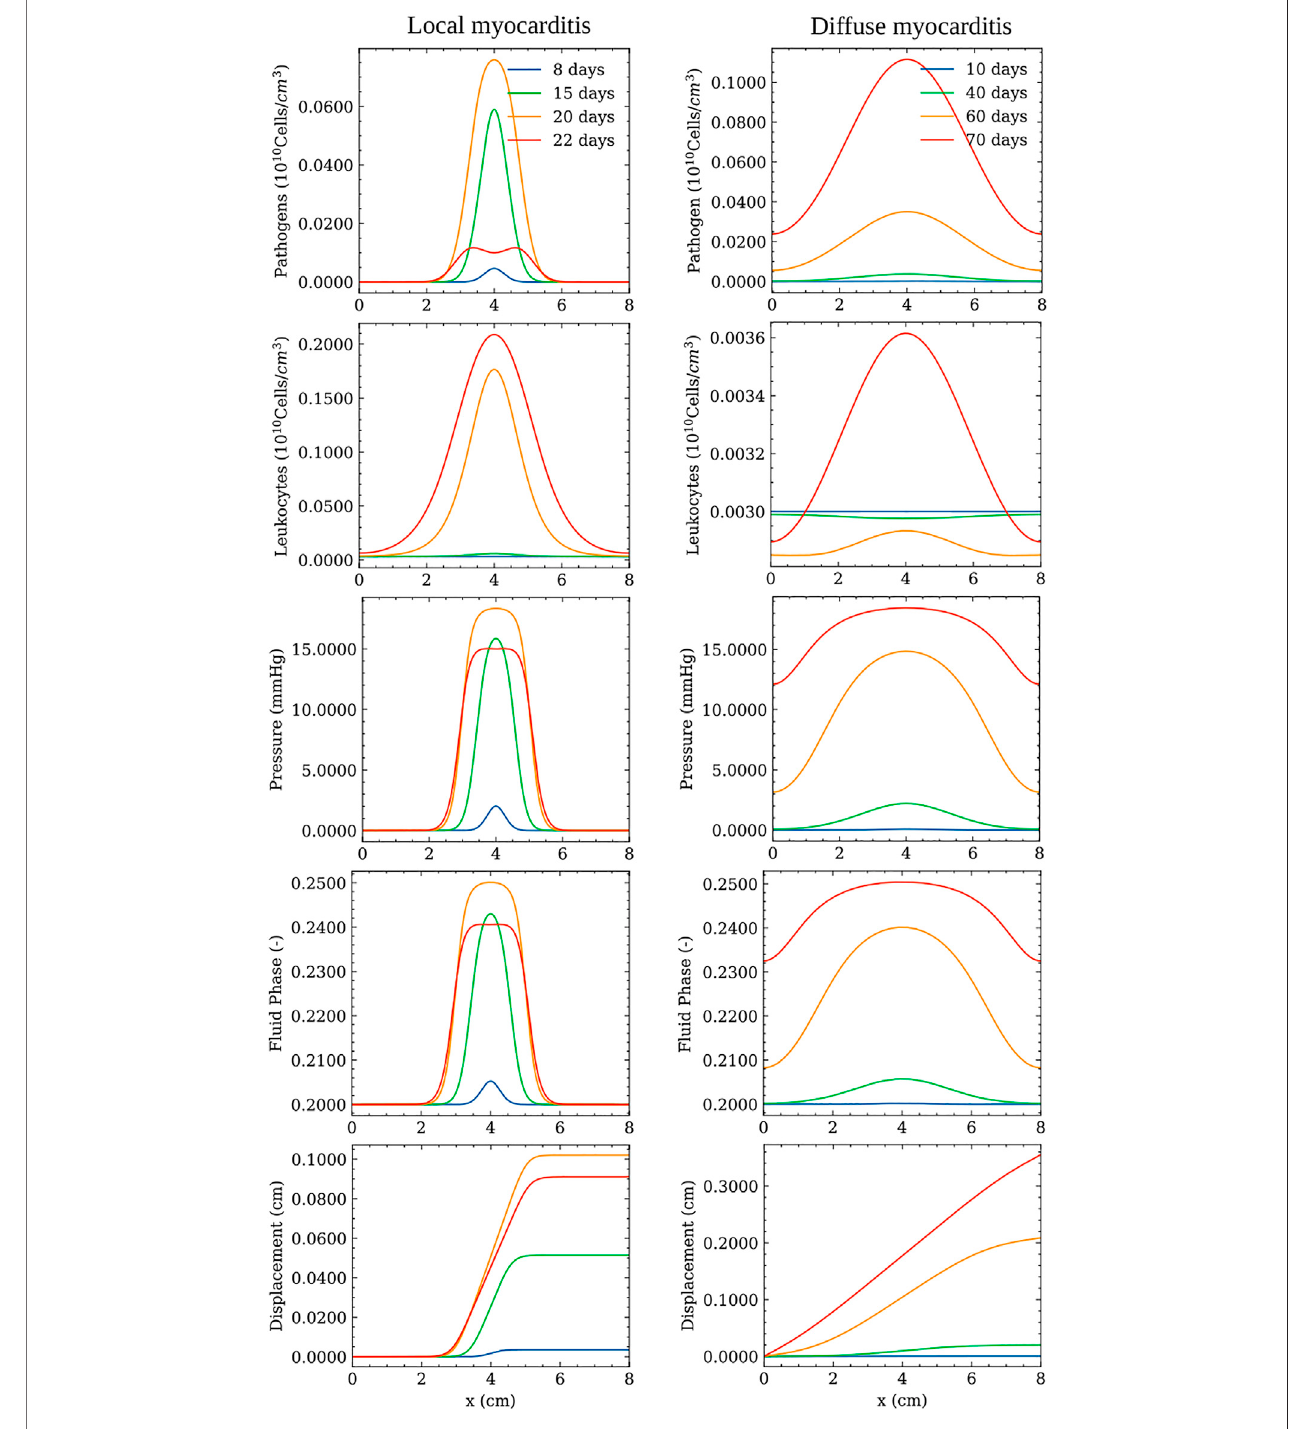
FIGURE 2 | Simulation of local (left) and diffuse (right) myocarditis dynamics in a one-dimensional domain using the reference parameter values described in Table 1 . Pathogen concentration, leukocytes concentration, pressure, displacement, and fl uid phase fi elds are presented at different time instants after the onset of infection.